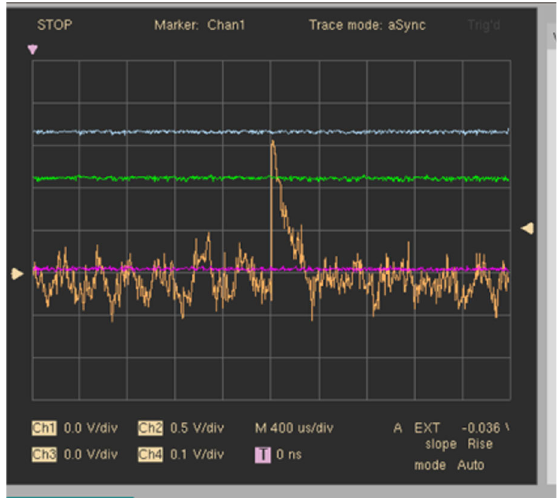
FIG. 22. Example of the signal (in orange) from the pyro-detector.